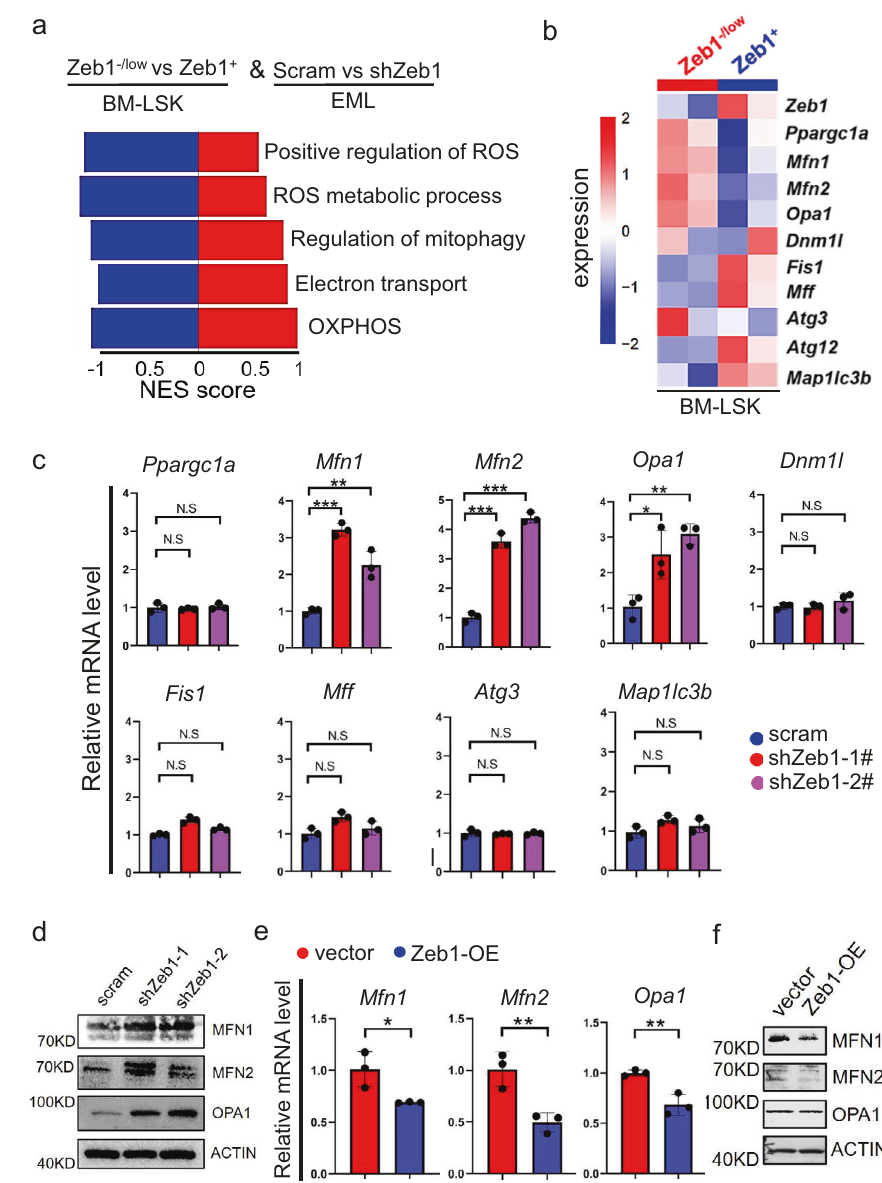
Fig. 5 Zeb1 suppresses mitochondrial fusion in EML cells. a GO analysis showing the top 5 biological process based on the overlapped DEGs from BM-LSKs (Zeb1 − /low and Zeb1 + -LSKs) and EMLs (EML-scramble and EML-shZeb1) cells. b Heatmap showing the expression of mitochondrial dynamic related genes in the Zeb1 − /low and Zeb1 + -LSKs. c RT-qPCR results showing the alteration of mitochondrial dynamic related genes in response to the downregulation of Zeb1 in EML cells. Data are represented as mean ± SD. * p < 0.01; ** p < 0.001; *** P < 0.0001. d Immunoblots showing the indicated proteins in EML-scramble, shZeb1-1# and shZeb1-2# cells. e RT-qPCR results showing the alteration of mitochondrial-fusion-related genes in response to ectopic expression of Zeb1 in EML cells. Data are represented as mean ± SD. * p < 0.01; ** p < 0.001. f Immunoblots of the indicated proteins in EML-vector and Zeb1-OE